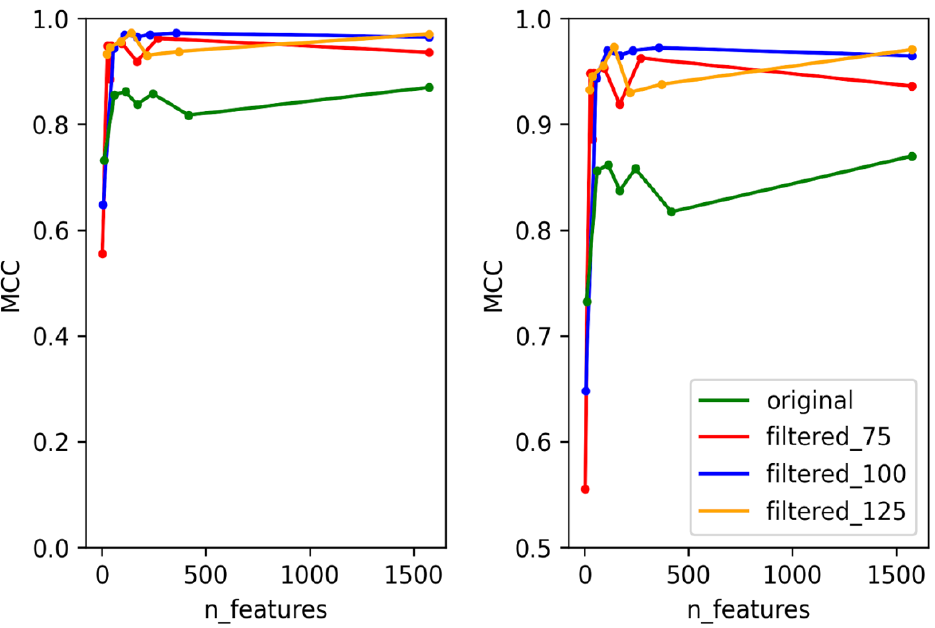
Figure 4. Test MCC of immunity repressor predictor using original dataset and filtered datasets using different numbers of features. Graph on the right shows the magnified section of the original graph with MCC ranging from 0.5 to 1.